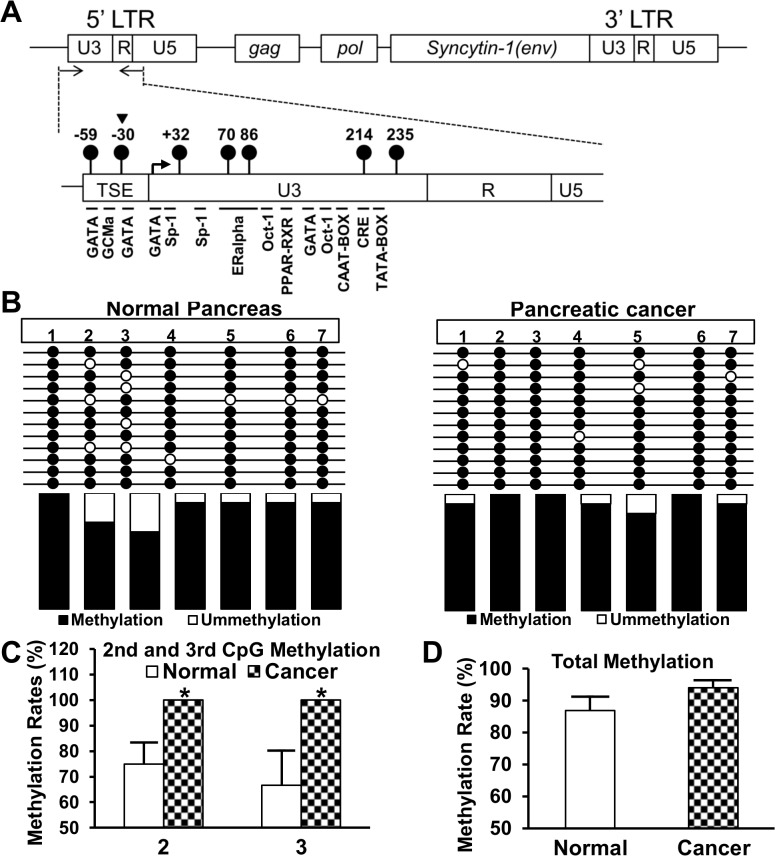
Bisulfite sequencing of the syncytin-1 gene 5’ LTR promoter region.Bisulfite-converted DNA from pancreatic normal (n = 4) and carcinoma (n = 4) tissues were PCR amplified, subcloned, and sequenced. A. Upper panel: Schematic map of HERV-W gene. Arrows show the location of PCR primers. Lower panel: The solid lollipops indicate the seven CpG sites in the PCR fragments and the numbers indicate the CpG positions. A triangle points to the second CpG site that was used for COBRA. TSE, a trophoblast-specific enhancer region, is directly upstream of 5’ LTR U3 region. Important cis-elements are highlighted below the PCR fragment. The angled arrow indicates the transcription start site. B. The sequencing result of syncytin-1 gene 5’ LTR promoter region. The solid and open circles represent the methylated or unmethylated cytosines, respectively, in CpGs dinucleotide contexts. The average methylation levels for each CpG site were shown in columns below. C. and D. Quantitative comparison of the syncytin-1 DNA methylation levels between pancreatic normal and carcinoma tissues. C. There was a significant increased methylation in the second and third CpG sites in pancreatic carcinomas than normal tissues. D. DNA methylation index of seven CpG sites showed a trend for increased methylation in pancreatic carcinomas compared to normal tissues, but the difference did not reach a statistical significance (P > 0.05). Data are expressed as Mean ± SEM. *: P < 0.05, as determined with Student’s t test.